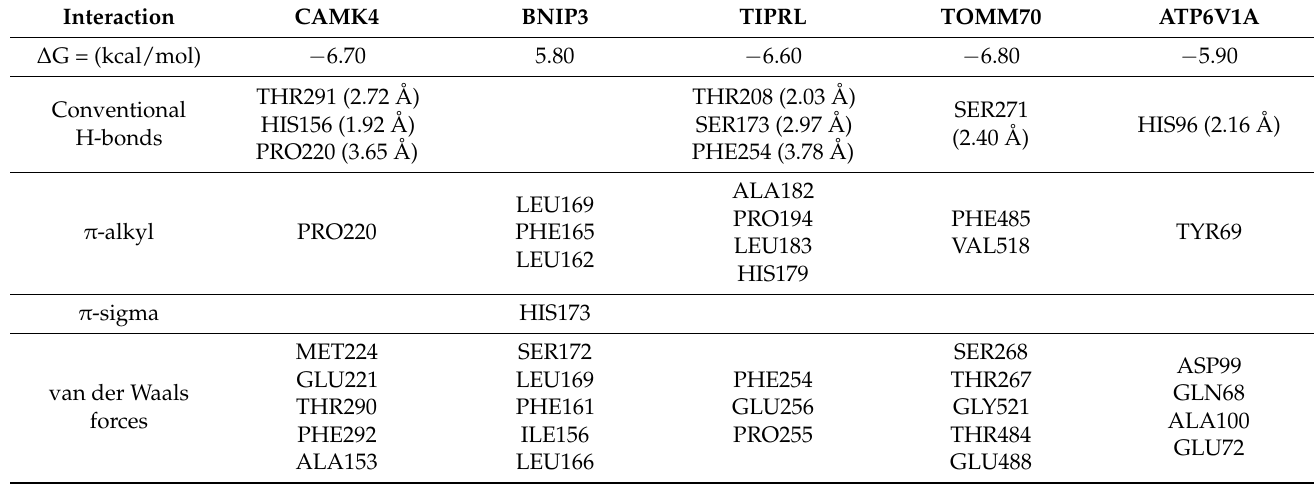
Table 6. Molecular docking profiles between antrocin and various